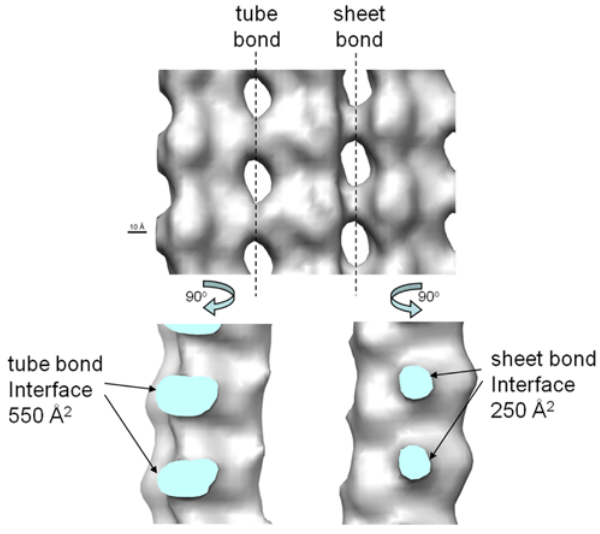
Figure 3. Course inspection of the electron density map of the ribbon structure. It reveals a clearly larger buried interface for